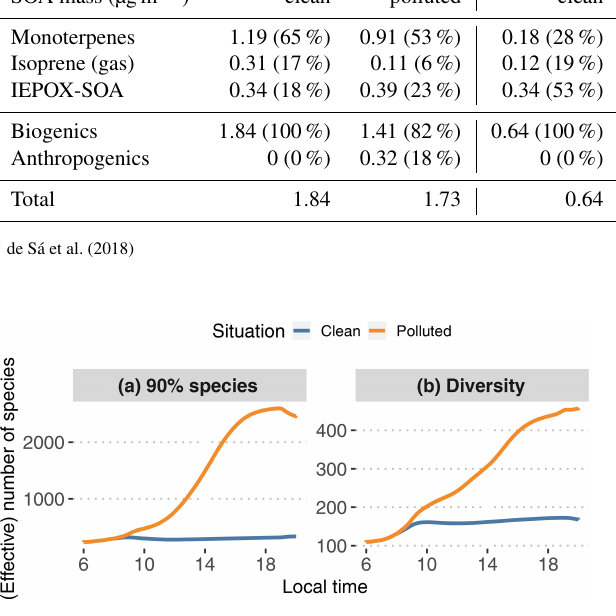
Figure 12. Smallest number of species needed to capture 90% of modeled SOA mass (a) with GECKO-A at each time step ( N 90% ; see text) and statistical diversity D in the GECKO-A modeled par- ticle phase ( b ; see Eq.